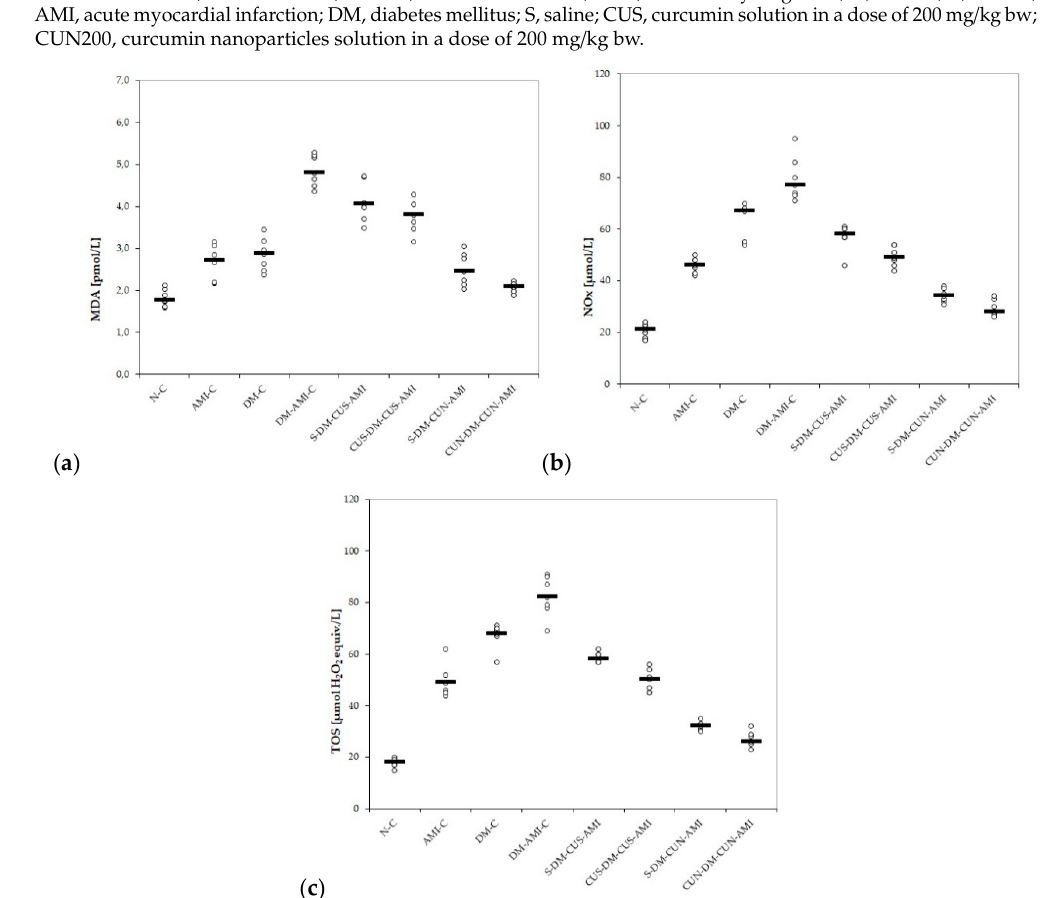
Figure 2. Variation by groups of serum oxidative stress intensity: ( a ) MDA (malondialdehyde), ( b ) NOx (nitric oxide), and ( c ) TOS (total oxidative status) by groups. Notes: The circles represent the individual values, and the horizontal line is given by the median. Abbreviations: N = normal; C = control; AMI = acute myocardial infarction; DM = diabetes mellitus; S = saline; CUS = curcumin solution in a dose of 200 mg / kg bw; CUN200 = curcumin nanoparticles solution in a dose of 200 mg / kg bw.